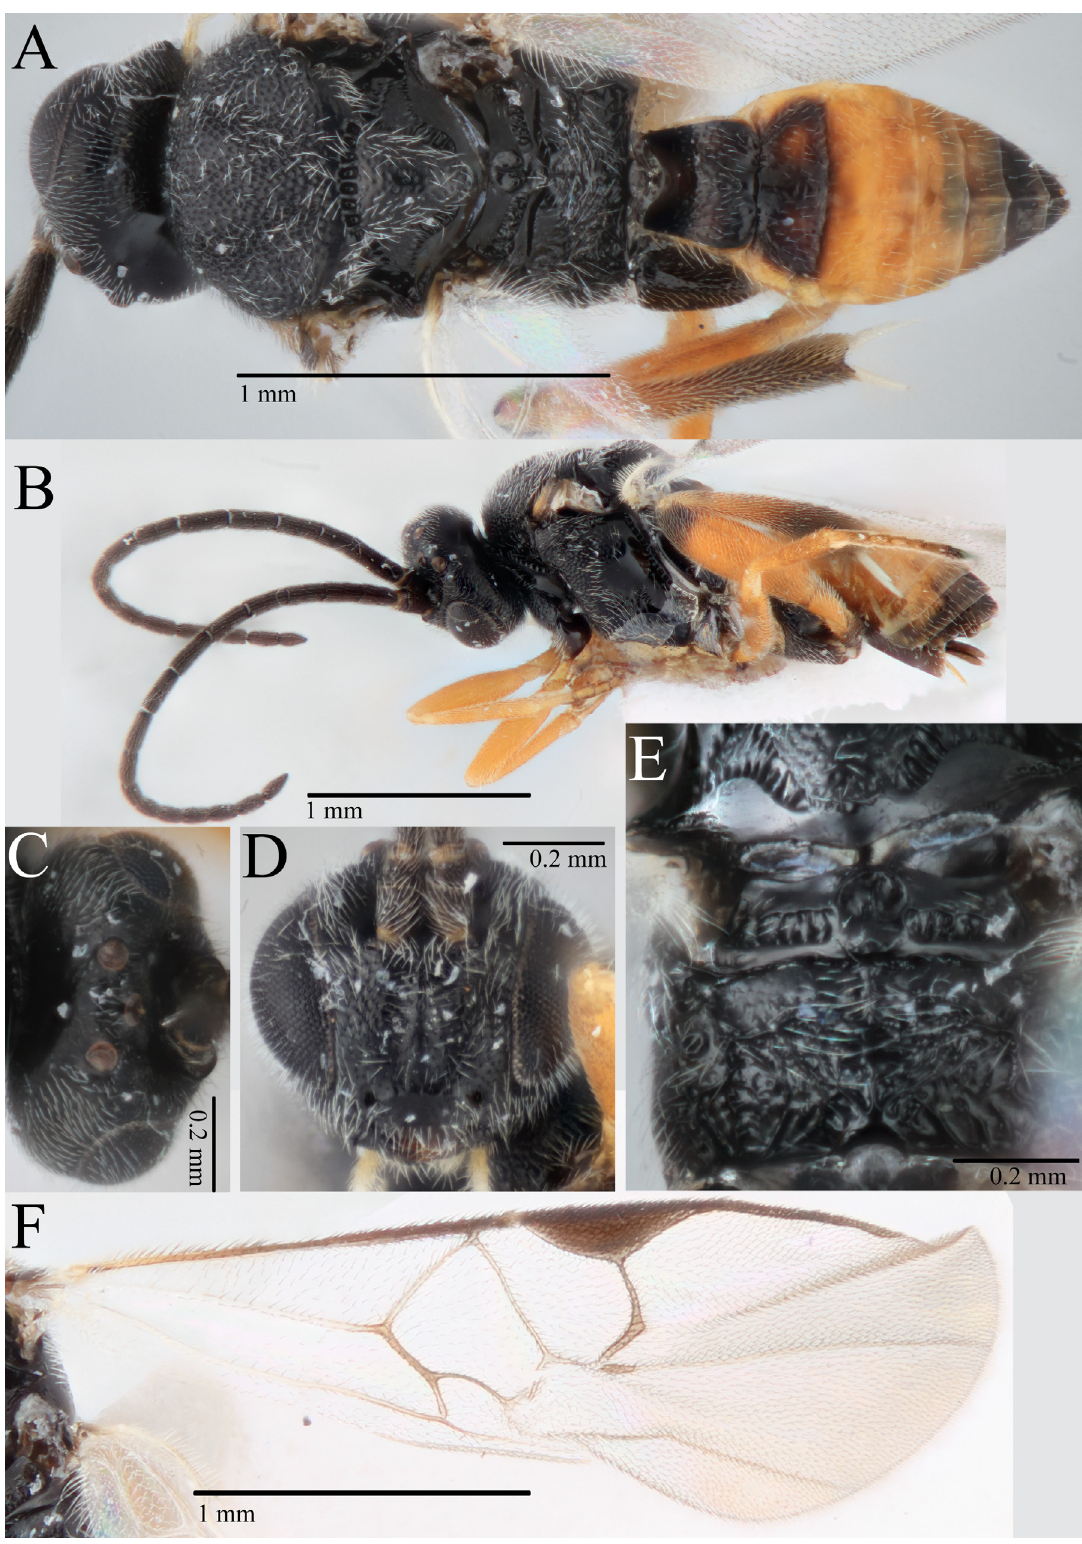
Fig. 25. Cotesia reidarum sp. nov., holotype, ♀ (QM T246703). A . Habitus in dorsal view. B . Habitus in lateral view. C . Head in dorsal view. D . Head in anterior view. E . Propodeum. F .